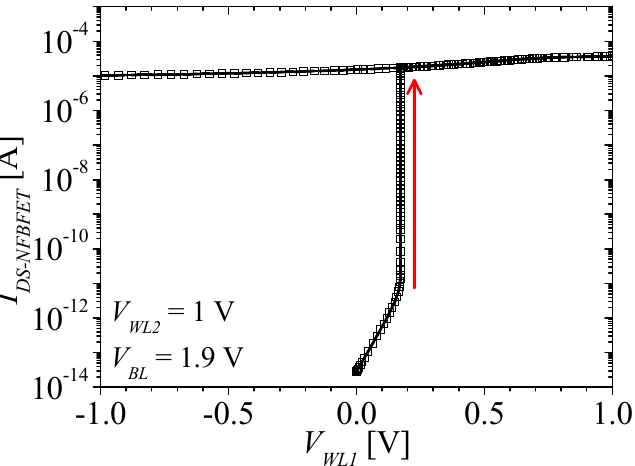
Figure 3. Drain − source current of the NFBFET ( I DS − NFBFET ) versus V WL1 when V BL = 1.9 V and V WL2 = 1 V.